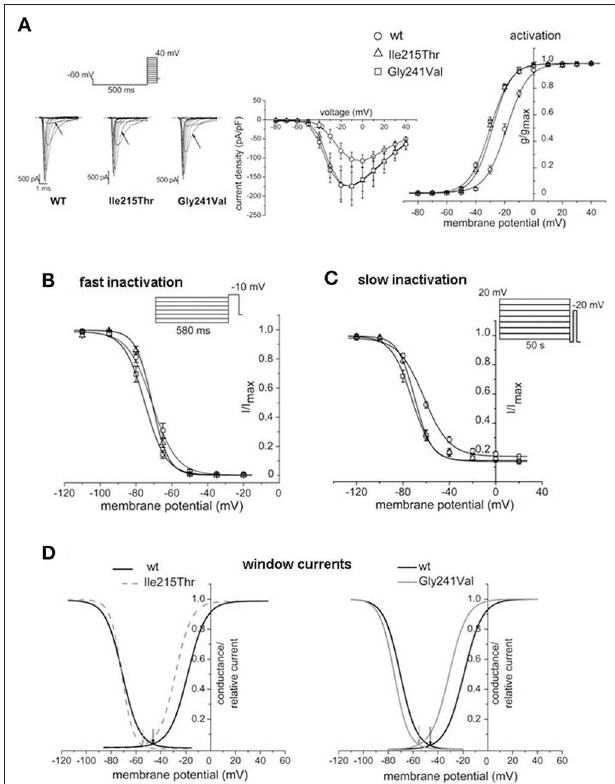
FIGURE 2 | Effects of p.Ile215Thr and p.Gly241Val mutations on Na v 1.4 functional properties. (A) Representative traces of whole-cell sodium currents; the arrows indicate the currents in response to the voltage step at − 30mV. Normalized current/voltage relationship was obtained by normalizing current by cell capacitance. Voltage dependence of activation was studied by applying the protocol represented and by fitting the normalized conductance by a Boltzmann curve. Comparison with WT indicates a shift of − 10 and − 12mV for the curves of p.Ile215Thr and p.Gly241Val, respectively. (B) Voltage dependence of fast inactivation. A mild shift toward hyperpolarized potentials is observed only for p.Gly241Val. (C) Slow inactivation properties studied with long conditioning voltage pulses. Changes in the V 1 / 2 are observed for both p.Ile215Thr and p.Gly241Val. (D) Window currents obtained overlapping activation and inactivation curves; they identify the voltage range in which Na v 1.4 channels are available for opening. p.Ile215Thr and p.Gly241Val show to be available to open in a more hyperpolarized voltage range compared to